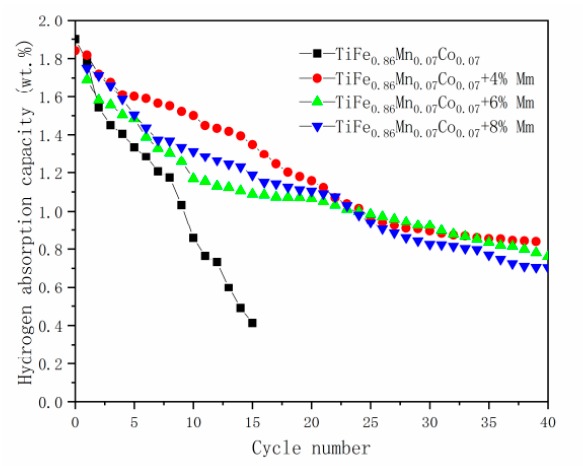
Figure 7. The cycle stability of TiFe 0.86 Mn 0.07 Co 0.07 + x% Mm (x = 0,4,6,8) alloys in H 2 containing 250 ppm O 2 .